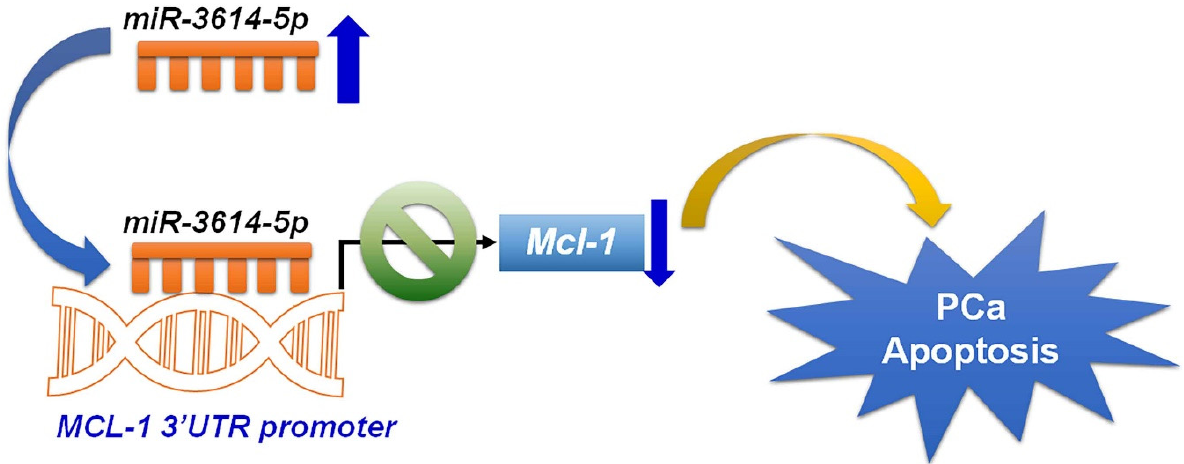
Figure 7. Schematic illustration of the overexpression of miRNA-3614-5p targeting Mcl-1 3 ′ -UTR and inhibition of Mcl-1 expression, leading to an apoptotic effect on human prostate cancer cells.